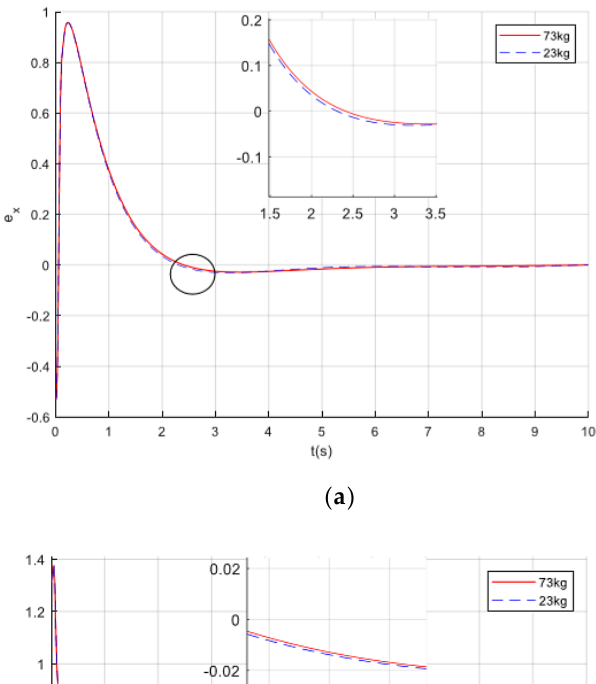
e ( a ), e ( b ), and angular error e x y